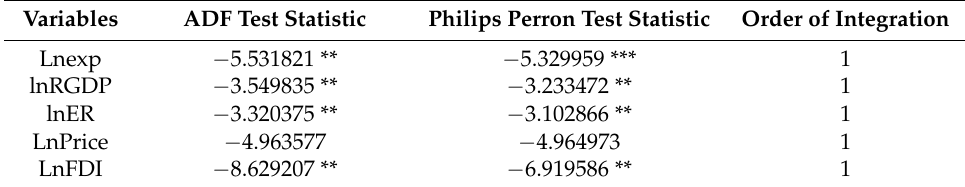
Table 3. Unit root tests at the first differences of the variables.